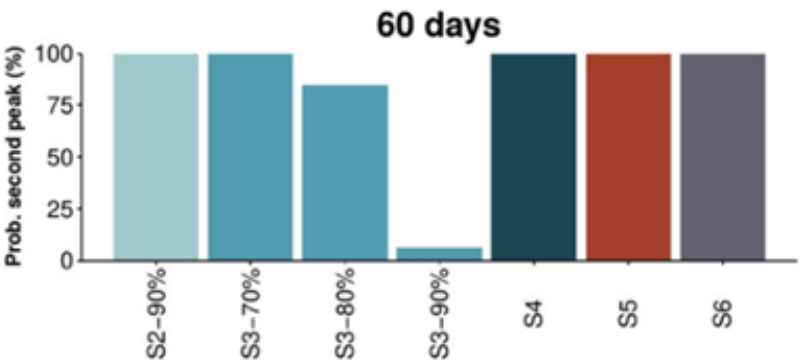
Figure 1. Mathematical model predictions for a strategy of total confinement [65]. Reproduced from [65].